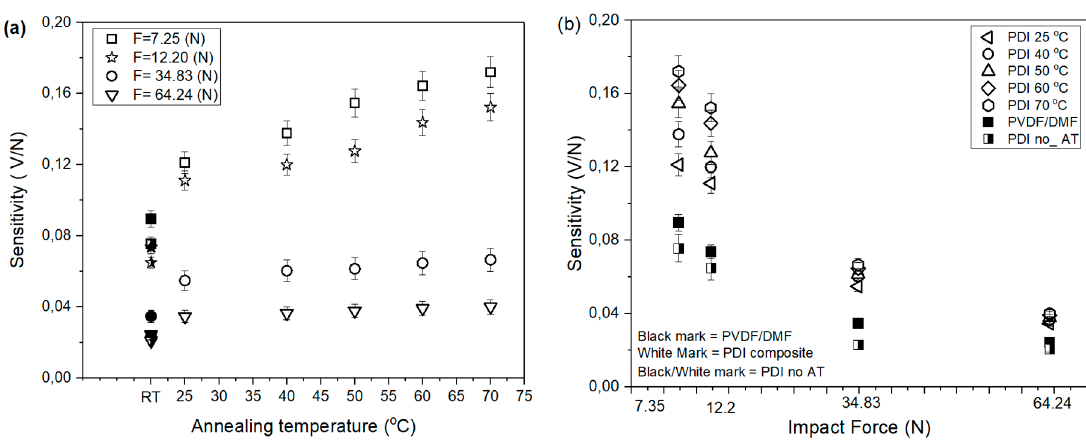
Figure 8. ( a ) Sensitivity ( d 33 ) vs. annealing temperature; ( b ) sensitivity vs. impact force.